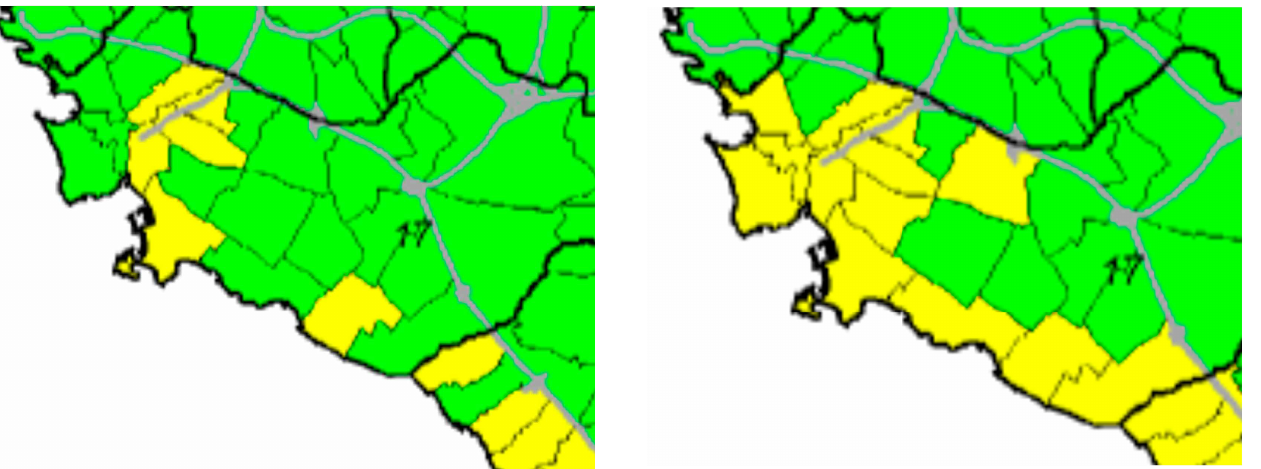
Figure 5: Map of number of damaged buildings of Kadiköy for model A [1].